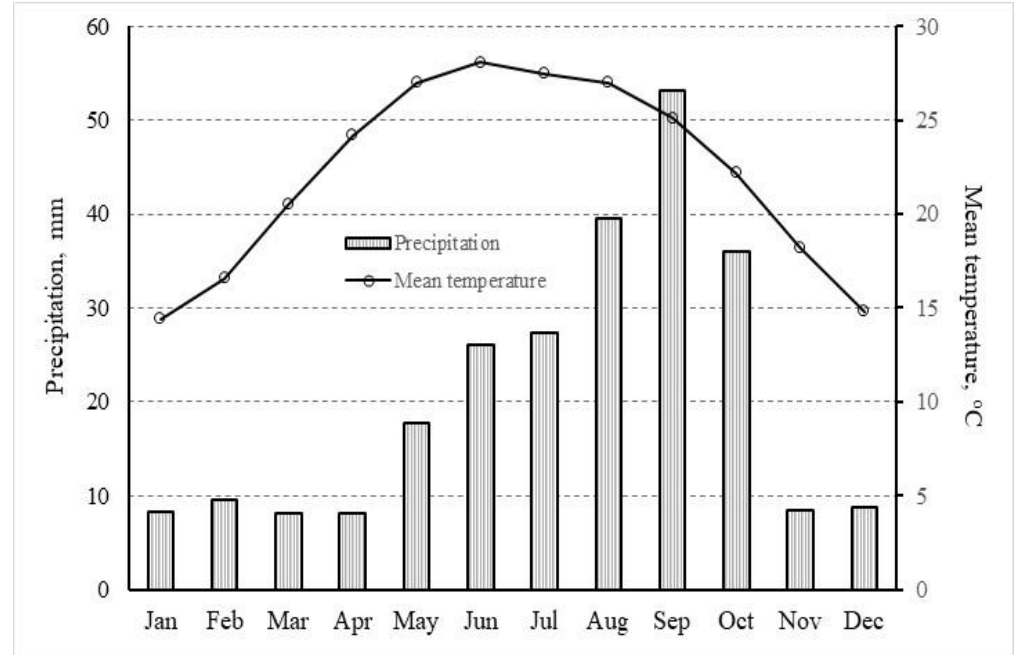
Figure 1. Monthly values of rainfall and temperature in Gómez Palacio, Durango State, Mexico.